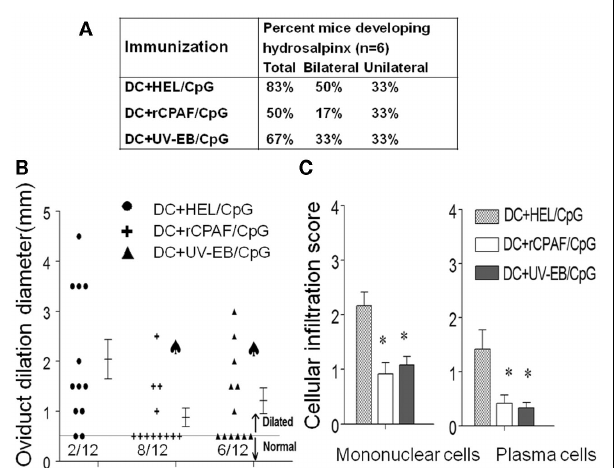
FIGURE 6 |The upper genital tract pathology was measured on day 80 after challenge. (A) Percentage of mice developing hydrosalpinx in different immunization groups after genital chlamydial challenge. (B) The oviduct dilation after vaccination and chlamydial challenge. Groups (six mice per group) were immunized s.c. with HEL + CpG, rCPAF + CpG, or UV-EB + CpG on day 0, and booster immunizations were given on day 14. One month after the final immunization, mice were challenged i.vag. with 5 × 10 4 IFU of C. muridarum . On day 80 after challenge, oviduct dilatation was measured. Each individual marker represents one oviduct, and the mean ± SEM of oviduct diameter per group of mice also is shown. ( ∗ ) Significant ( p < 0.05, chi-square test) difference in oviduct diameter between the indicated group and HEL + CpG-pulsed group, respectively. (C) On day 80 after challenge, infiltration of mononuclear cells and plasma cells were scored.The means ± SEM of the scores per group are shown. ( ∗ ) Significant differences ( p < 0.05; Kruskal–Wallis one-way ANOVA on ranks) between the indicated groups and HEL + CpG-pulsed group are